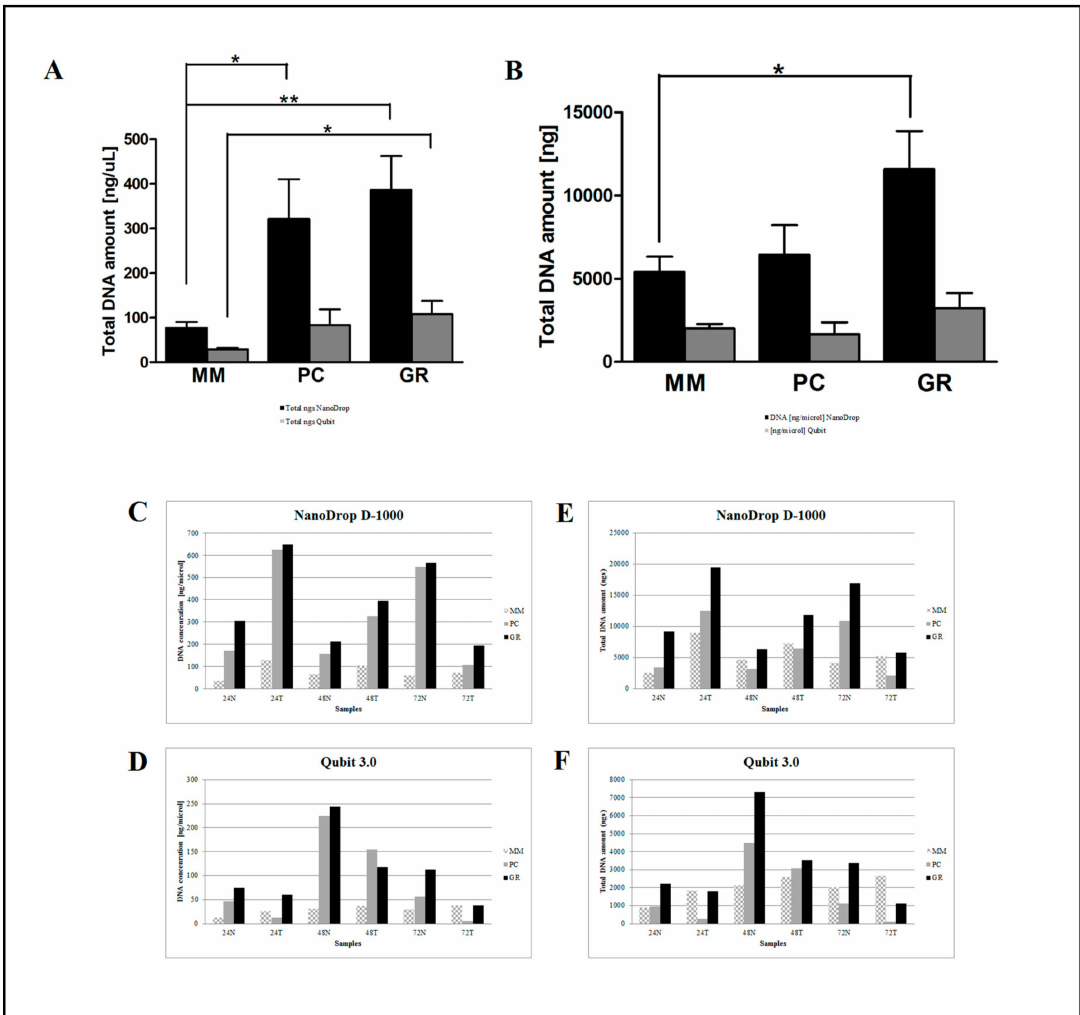
Figure 2. Comparison of the three manual DNA extraction systems (MM, PC and GR). Mean of DNA concentration (ng / µ L) and total DNA (ng) as measured by the NanoDrop D-1000 spectrophotometer ( A ) and Qubit 3.0 fluorometer ( B ) . Total DNA amount (ng) measured by the NanoDrop D-1000 spectrophotometer ( E ) and Qubit 3.0 fluorometer ( F ) and DNA concentration (ng / µ L) measured by the NanoDrop D-1000 spectrophotometer ( C ) and Qubit 3.0 fluorometer ( D ) for the 24N, 24T, 48N, 48T, 72N, and 72T samples. * p < 0.05, ** p < 0.001, *** p < 0.0001 t